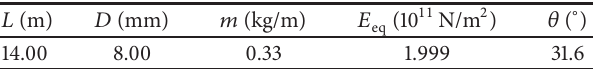
Table 1: Material properties and geometric parametric vibration of the stayed cable